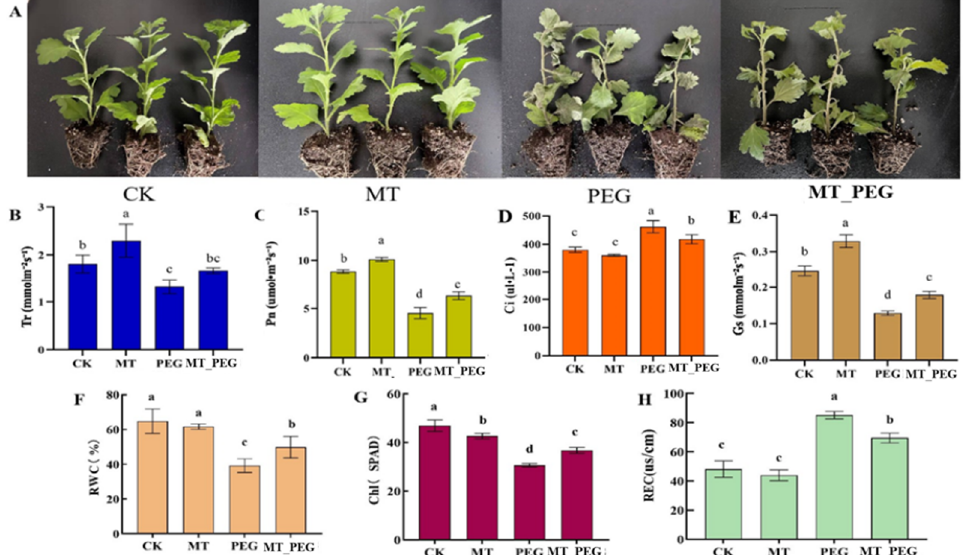
Figure 1. Effects of melatonin on chrysanthemum seedlings and their chlorophyll content and photosynthetic capacity under drought stress. ( A ) Phenotypes after 12 days of drought stress treatment. ( B ) Tr (Transpiration rate). ( C ) Pn (Net photosynthetic rate). ( D ) Ci (Intercellular carbon dioxide con- centration); ( E ) Gs (Stomatal conductance). ( F ) RWC (Relative Water Content). ( G ) Chl (Chlorophyll content). ( H ) REC (Relative conductivity). CK, control; MT, exogenous melatonin treatment; PEG, drought stress; MT_PEG, drought stress with exogenous melatonin treatment. The data are